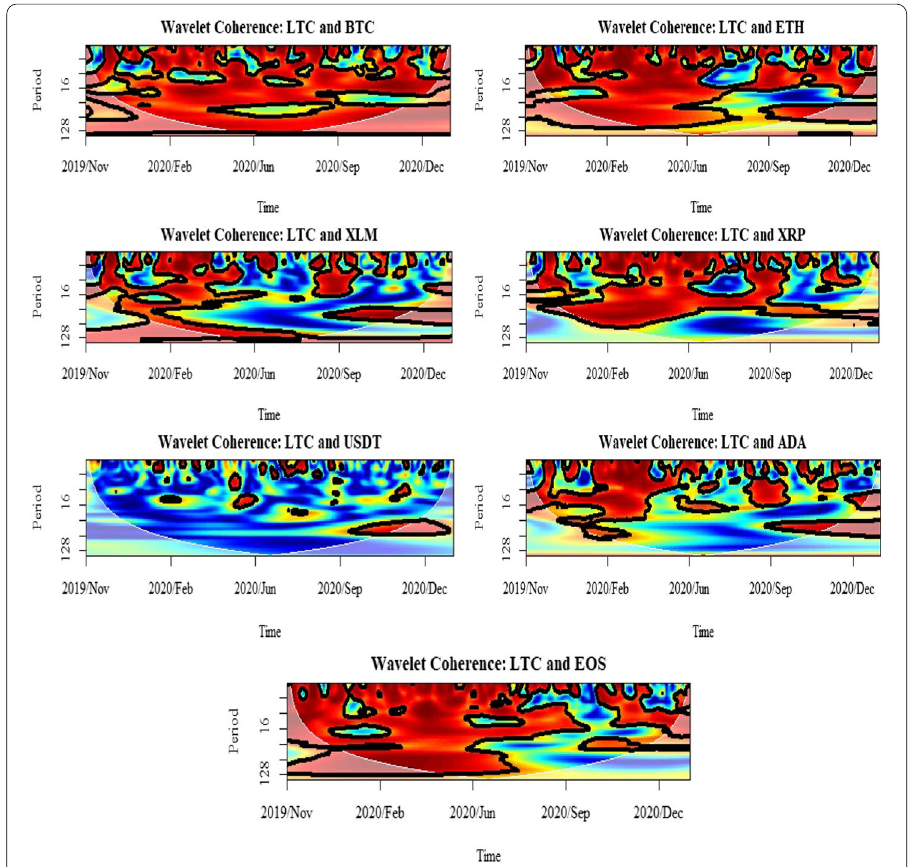
Fig. 8 Results for wavelet coherence: LTC